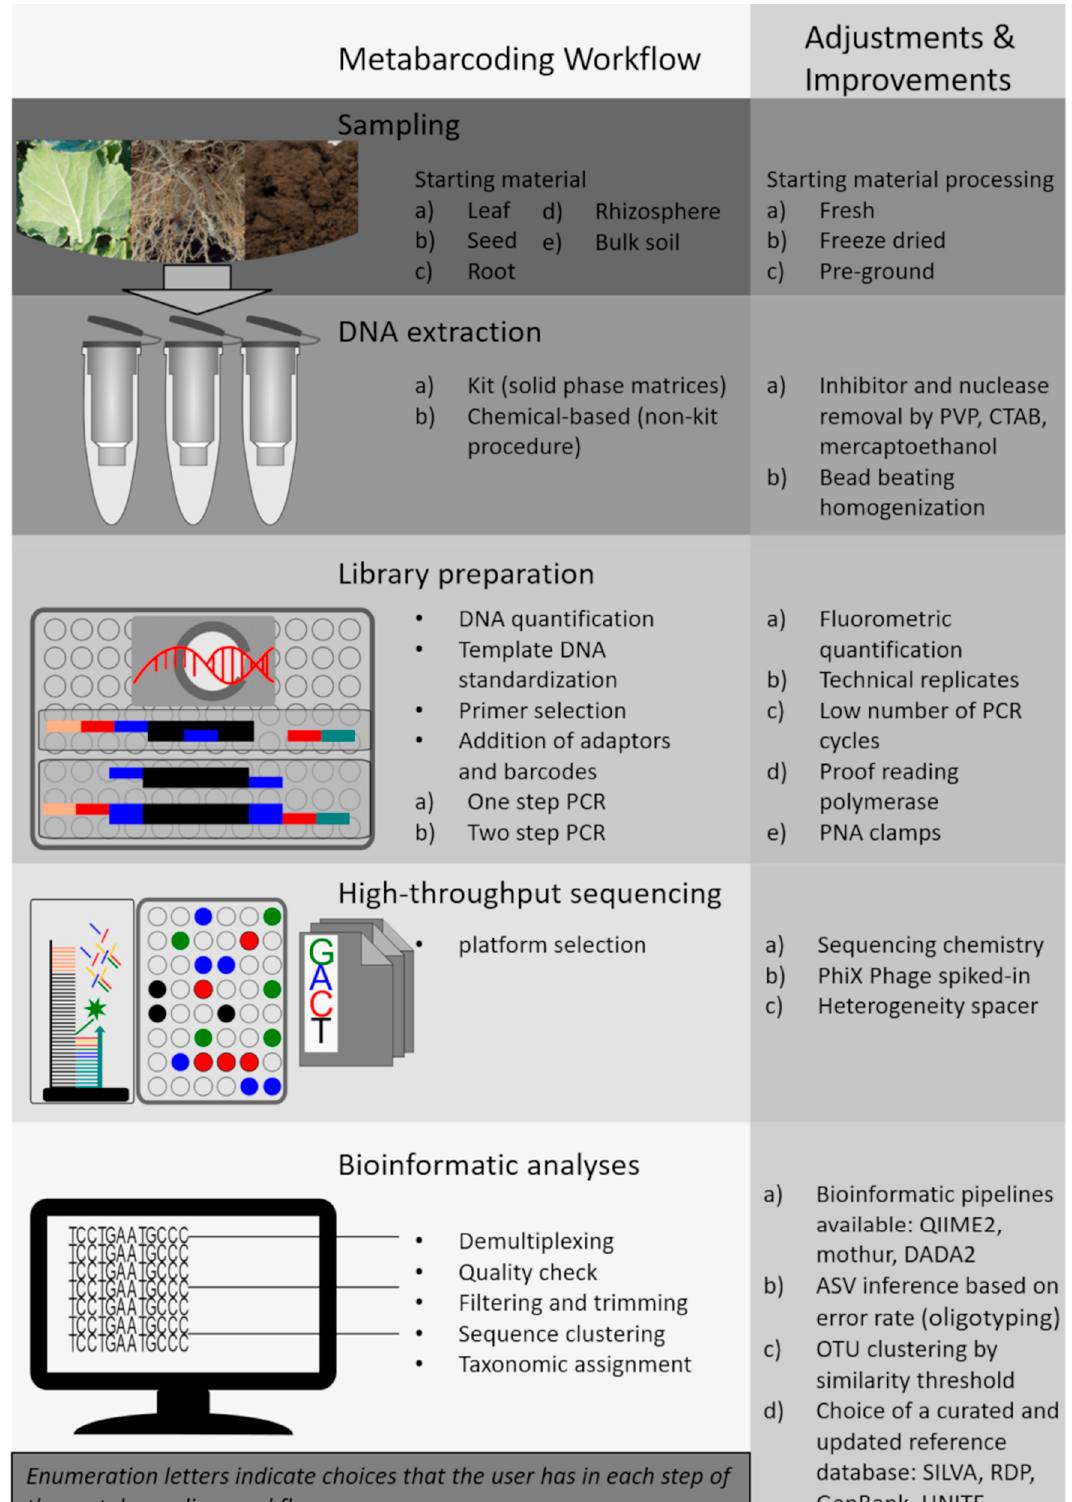
Figure 1. DNA metabarcoding workflow with suggested adjustments and improvements.